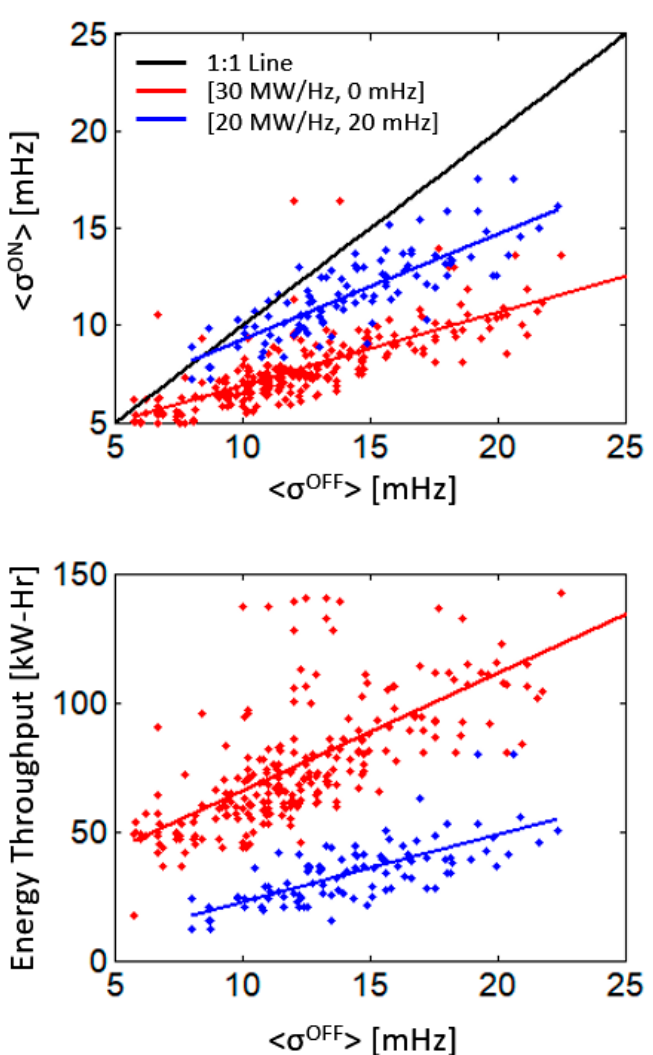
Figure 6. Top : A plot of the frequency variability metric for 20-min periods when the BESS was ON, versus adjacent 20-min periods when the BESS was OFF, from multiple experiments using the (0 MW/Hz, 0 mHz) (red dots) and (20 MW/Hz, 20 mHz) (blue dots) parameter sets. Bottom : A plot of the energy throughput in kW-H for each 20-min period when the BESS was ON, versus the background grid frequency variability of the adjacent 20-min period with the BESS OFF.